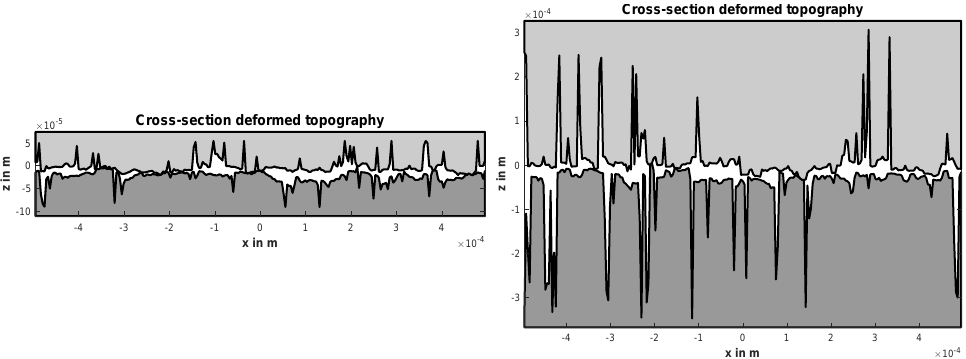
Figure 16. Cross-section of simulation results: ( left ) upwards- and ( right ) sidewards-facing